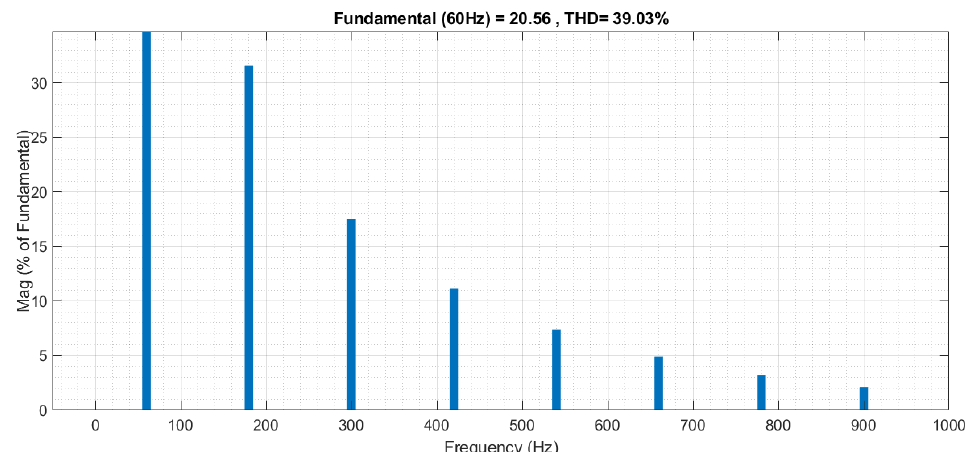
Figure 14. Rate harmonic distortion I S before